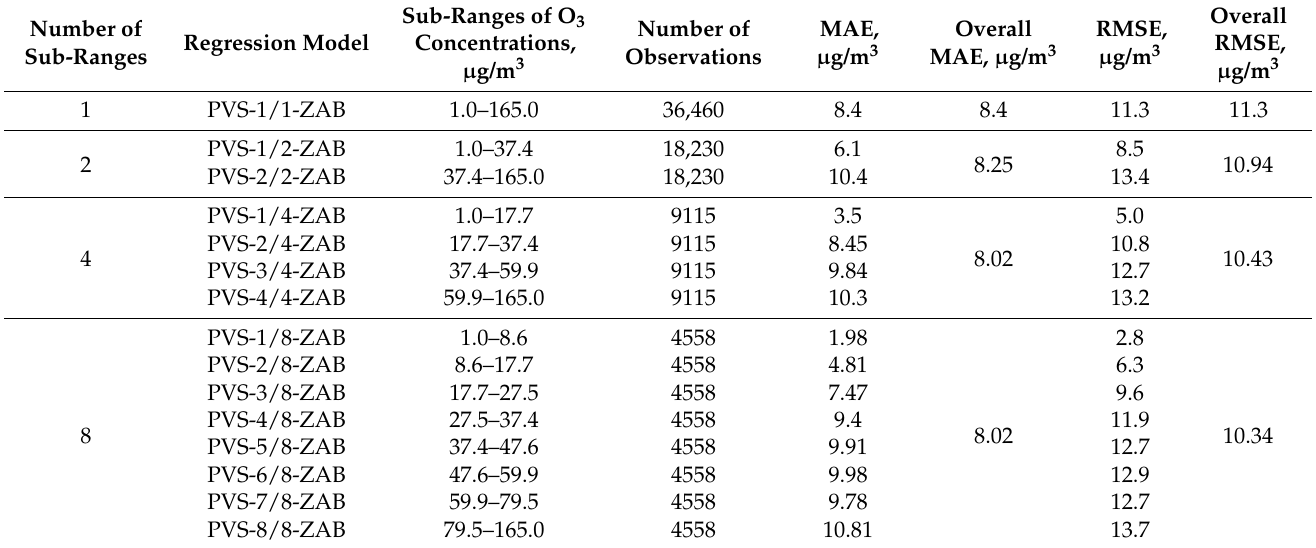
Table 3. Values of approximation errors of O 3 concentrations in PVS models, Zabrze 2011–2016.